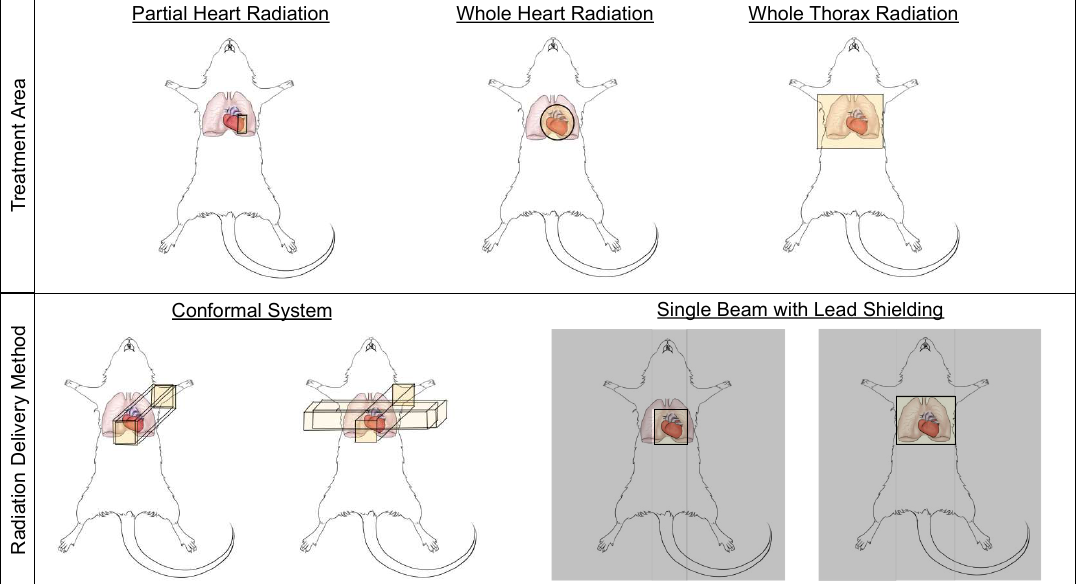
Figure 2. Small animal irradiation techniques allow a wide variety of cardiac and pulmonary exposures and a number of delivery methods. Schematic illustrations of radiation field options that are commonly used to deliver cardiac radiation (top panel), and methods of radiation delivery (bottom panel) in small animal models of radiation-induced heart dysfunction